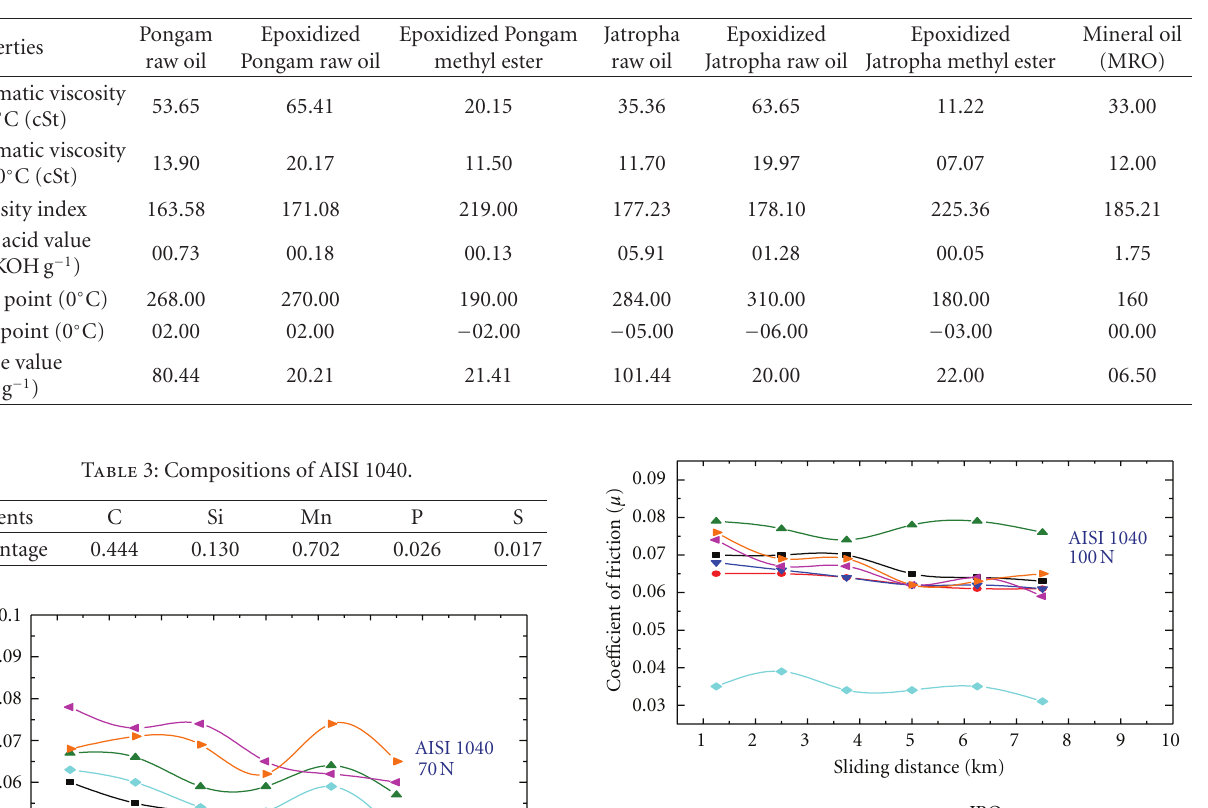
Table 2: Physicochemical properties of raw and modified oils.